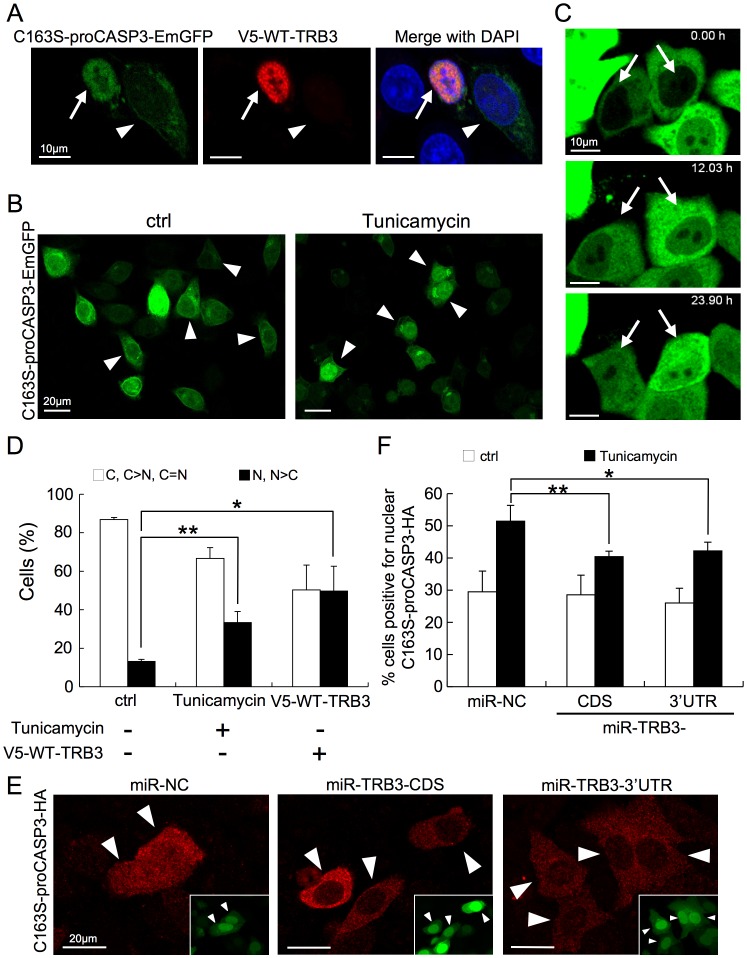
TRB3 expression induces nuclear translocation of proCASP3.(A) HeLa cells were cotransfected with the C163S-proCASP3-EmGFP and V5-WT-TRB3 expression plasmids. After 24 hr, the cells were stained with anti-V5 antibody (red) and counterstained with DAPI (blue). Arrow and arrowhead indicated V5-WT-TRB3 positive and negative cells respectively. Scale bars = 10 µm. (B) Twenty-four hours after transfection with the C163S-proCASP3-EmGFP expression plasmid, HeLa cells were incubated with or without tunicamycin for 8 hr. Arrowheads showed representative phenotypes of C163S-proCASP3-EmGFP localization in each condition. Scale bars = 20 µm. (C) Twenty-four hours after transfection with the C163S-proCASP3-EmGFP expression plasmid, HeLa cells were treated with tunicamycin, and localization of C163S-proCASP3-EmGFP was simultaneously monitored for 24 hr by live imaging. Representative frames displaying scenes of nuclear translocation (arrows) are shown. Scale bars = 10 µm. (D) Localization of C163S-proCASP3-EmGFP was quantified as cytoplasmic, mainly cytoplasmic or cytoplasmic equal to nuclear (C, C>N, C = N), or as nuclear or mainly nuclear (N, N>C) under conditions described above (Figure 4A, V5-WT-TRB3; Figure 4B, ctrl or Tunicamycin). This localization was also assessed in cells coexpressing V5-WT-TRB3 (right bar graph). Over 30 cells were assessed in three independent experiments. Error bar: mean ±SD. *P<0.01, **P<0.005. (E) HeLa cells were cotransfected with the C163S-proCASP3-HA and indicated artificial miRNA expression plasmids. After 24 hr, the cells were incubated with tunicamycin for 8 hr. The localization of C163S-proCASP3-HA was observed by immunofluorescence staining with an anti-HA antibody (red). The miRNA expressing cells of inner panel were visualized by cocistronic expression of EmGFP. Arrowheads showed the C163S-proCASP3-HA expressing cells. Scale bars = 20 µm. (F) The cells positive for nuclear C163S-proCASP3-HA (N, N>C, N = C) were quantified by immunofluorescence staining with an anti-HA antibody. Over 30 cells positive for EmGFP were assessed in six independent experiments. Error bar: mean ±SD. *P<0.005, **P<0.001. miR-NC denotes negative control miRNA.